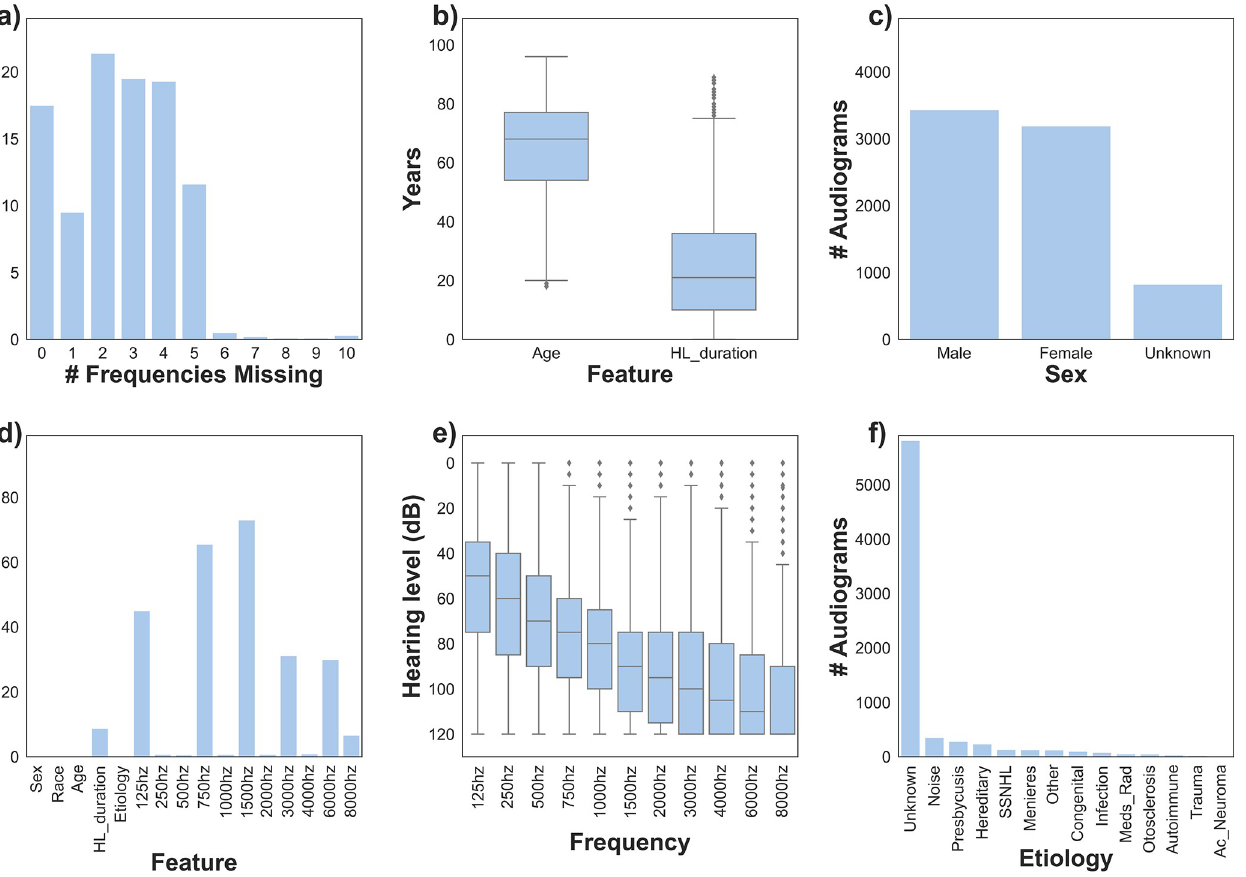
Fig 4. Demographics. Descriptive statistics for raw sparse audiometric dataset (n = 7,451).